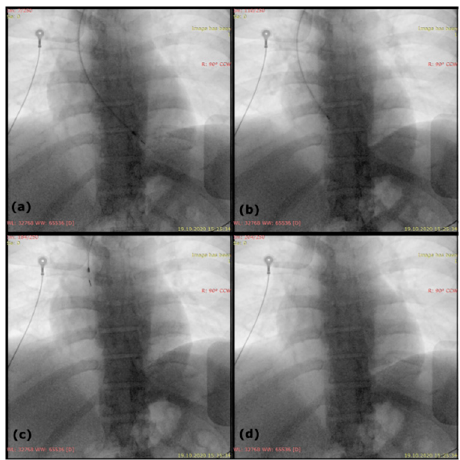
Figure 5. Antero-posterior fluoroscopic view of the lead extraction: ( a ) lead in the right ventricle; ( b ) lead in the right atrium; ( c ) lead in superior vena cava; ( d ) fluoroscopic view after lead extraction.